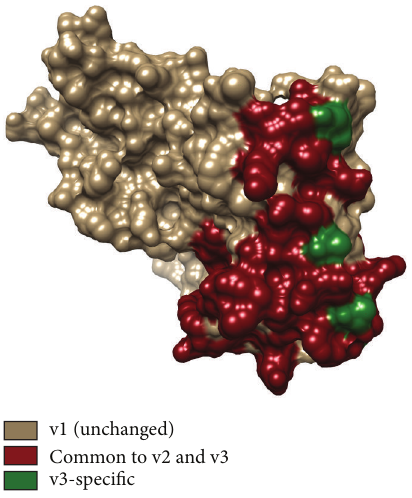
Figure 2: Broad coverage chimeric fHbp generated by rational design as described in [21]. The surface of variant 1 fHbp used as a scaffold is shown in brown. The engineered area carrying heterologous epitopes is colored in dark red (residues in common between variant 2 (V2) and variant 3 (V3)) and in green (variant 3- specific